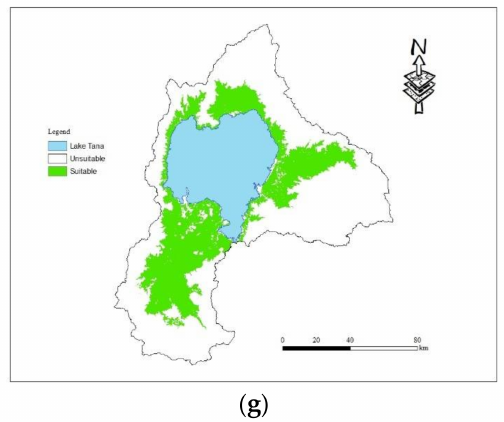
Figure A1. Applicability of different water-lifting technologies. ( a ) bucket pump; ( b ) direct action hand pump; ( c ) deep wells’ diaphragm pump; ( d ) deep wells’ piston hand pump; ( e ) rope pumps; ( f ) Rope and bucket pumps; ( g ) suction plunger hand